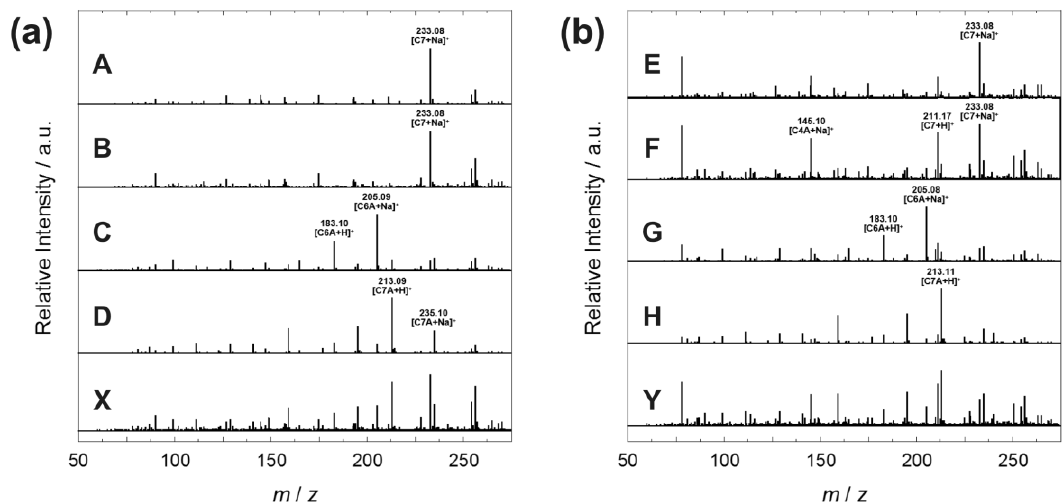
Figure 5. Mass spectra obtained in the LC-MS measurements for the products of the formose reaction carried out using 1 M formaldehyde and 120 mM calcium hydroxide at 60 °C for 180 min in the presence of 10 g·L −1 pDMA/VBA ( a ) and 0.5 mM PBA ( b ). Spectra A–H were recorded at the maxima of signals A–H in Figure 4. Spectra X and Y are the total mass spectra recorded in the region of 7–14 min in Figure 4a,b, respectively. C n and C n A denote n -carbon monosaccharide and sugar alcohol, respectively.